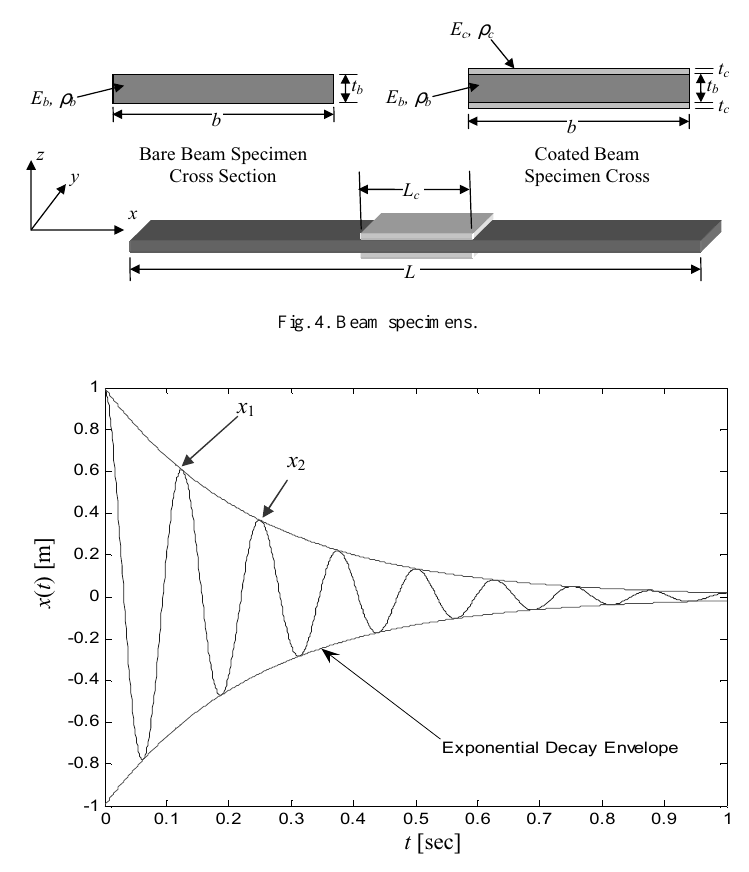
Fig. 5. Free decay of a damped single degree of freedom